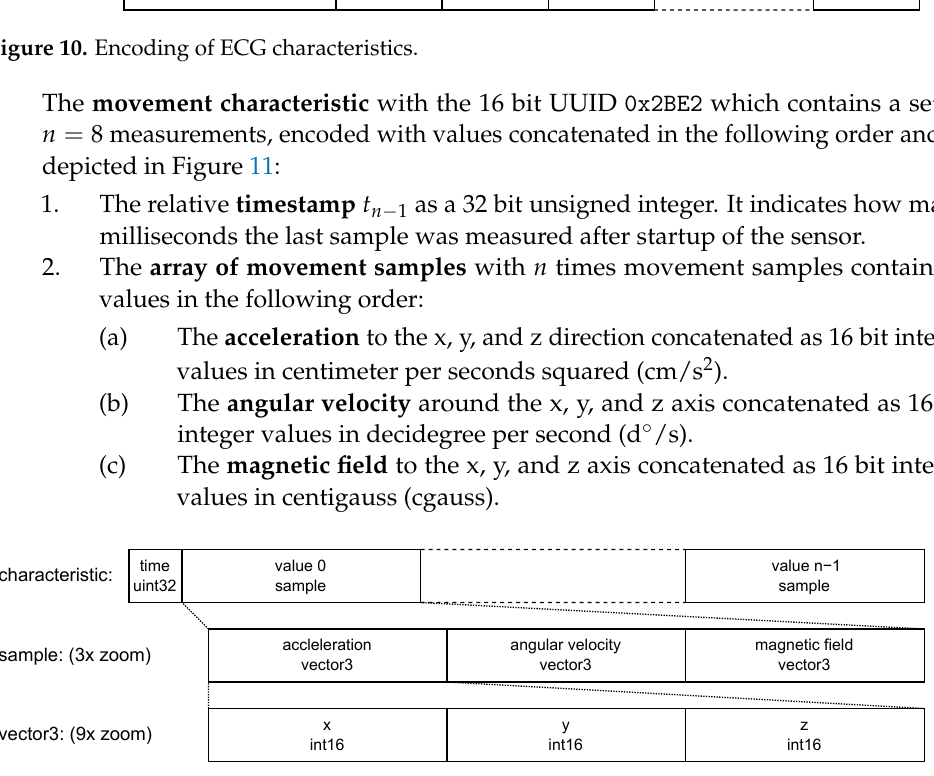
Figure 11. Encoding of movement